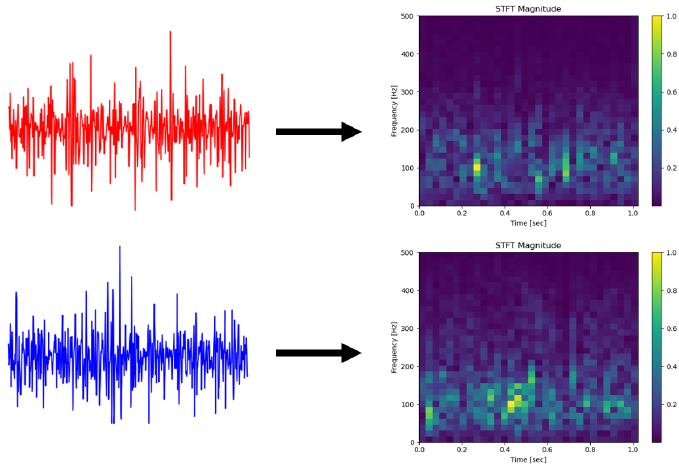
Figure 2. Two processed surface EMG samples and their STFT spectrogram (Hanning window, window length = 64).